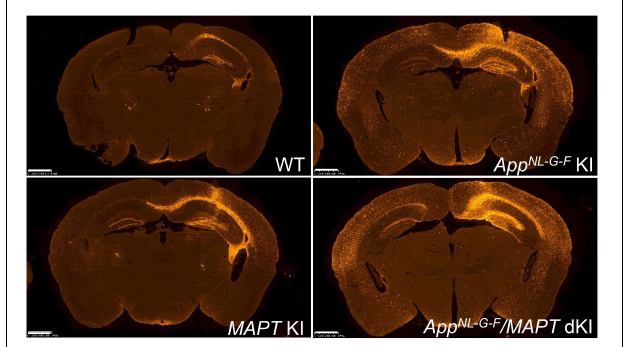
each mouse line was observed 3 months after AD-tau injection. Brain sections were immunostained with AT8 (red). Humanization of the host animal tau affects the transmission of the pathogenic agents. App NL − G − F /MAPT dKI mice exhibited greater pathological propagation than App NL − G − F KI